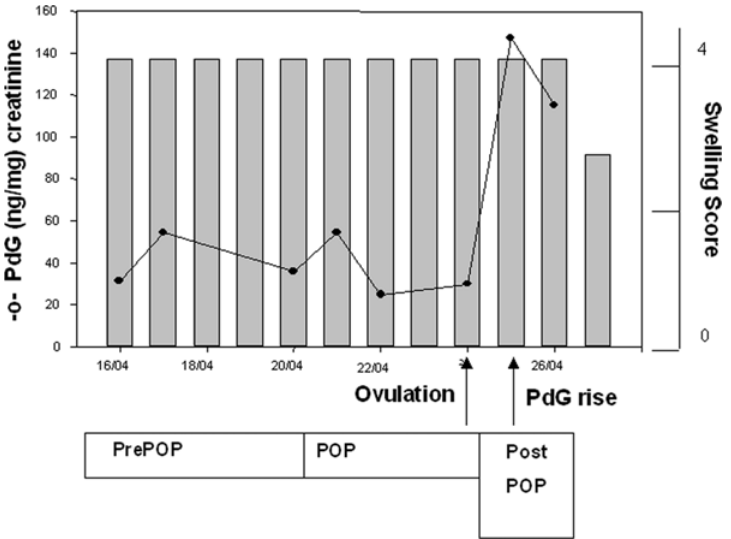
Figure 6. Chimpanzee ovulation profile . Profiles of urinary pregnandiol in ng/mg creatinine and perineal swelling for the adult female WL during April 2007. POP: periovulatory or fertile period, defined as the day of ovulation plus the three preceding days; PrePOP: period of maximum tumescence prior to POP PostPOP: period of maximum tumescence following POP